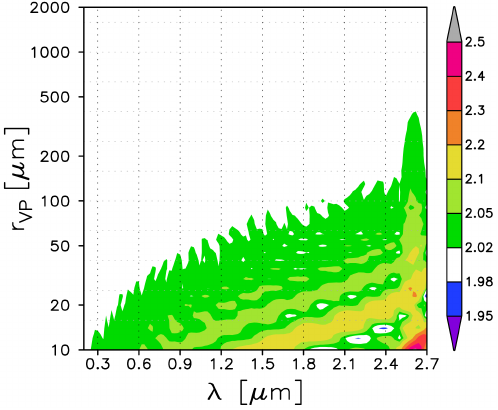
Figure 7. Extinction efficiency Q ext for the optimized habit combi- nation as a function of wavelength ( λ ) and volume-to-projected area equivalent radius ( r vp